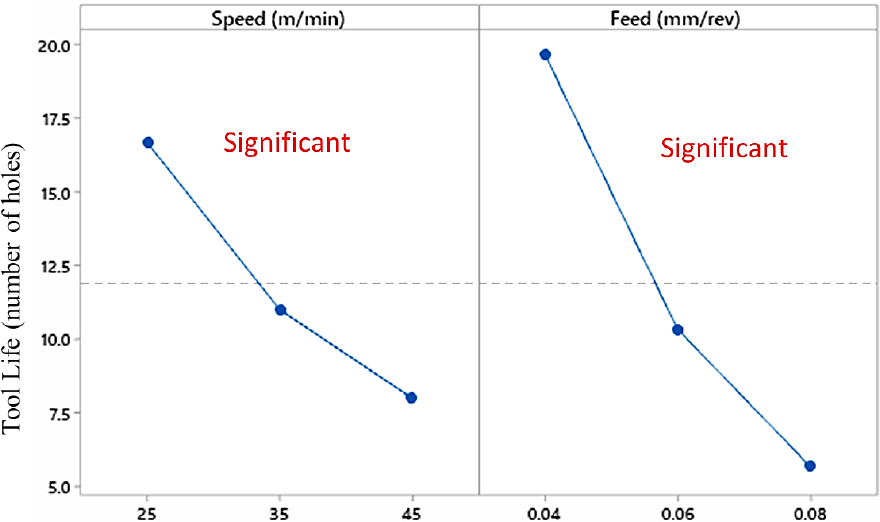
Figure 10. Tool life with respect to number of holes.